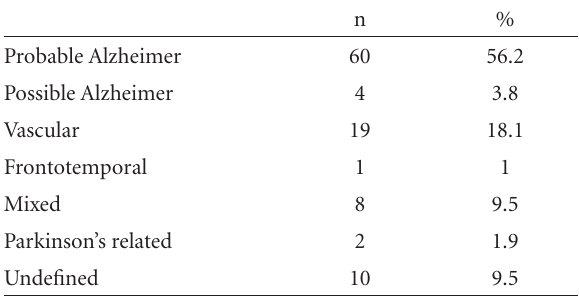
Table 1. Dementia type frequency.